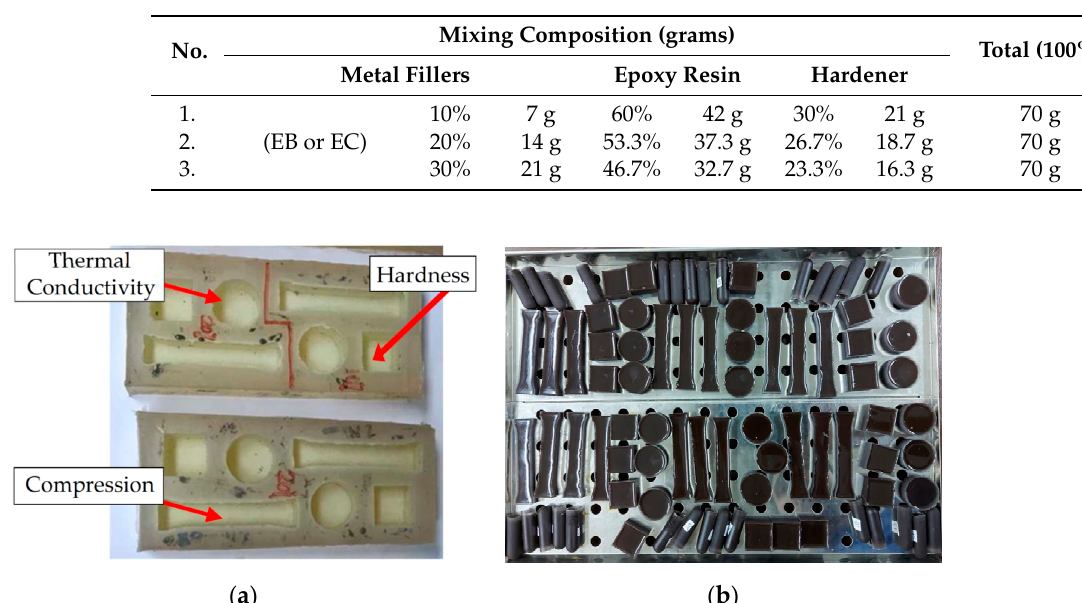
Table 2. Composition of Metal Epoxy Composite (MEC) for 1 set specimen (thermal, compression and hardness).